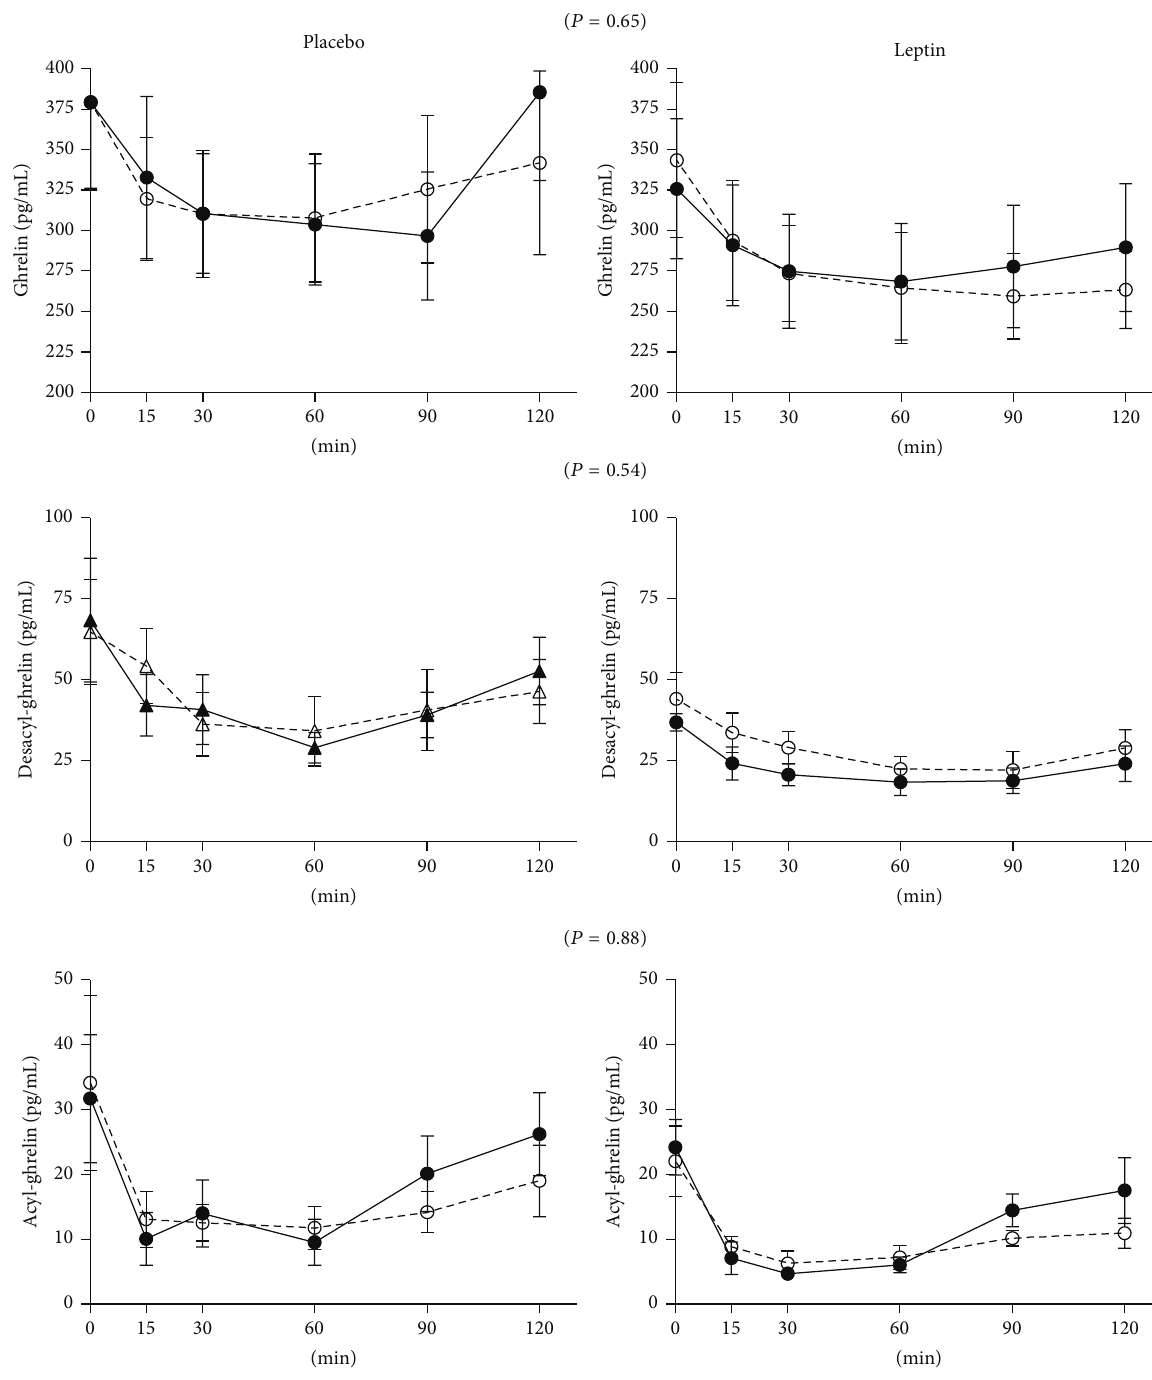
Figure 2: Fasting and postprandial plasma levels of total ghrelin, acyl-ghrelin, and desacyl-ghrelin (open circles and dashed line, week 0; closed circles and solid line, week